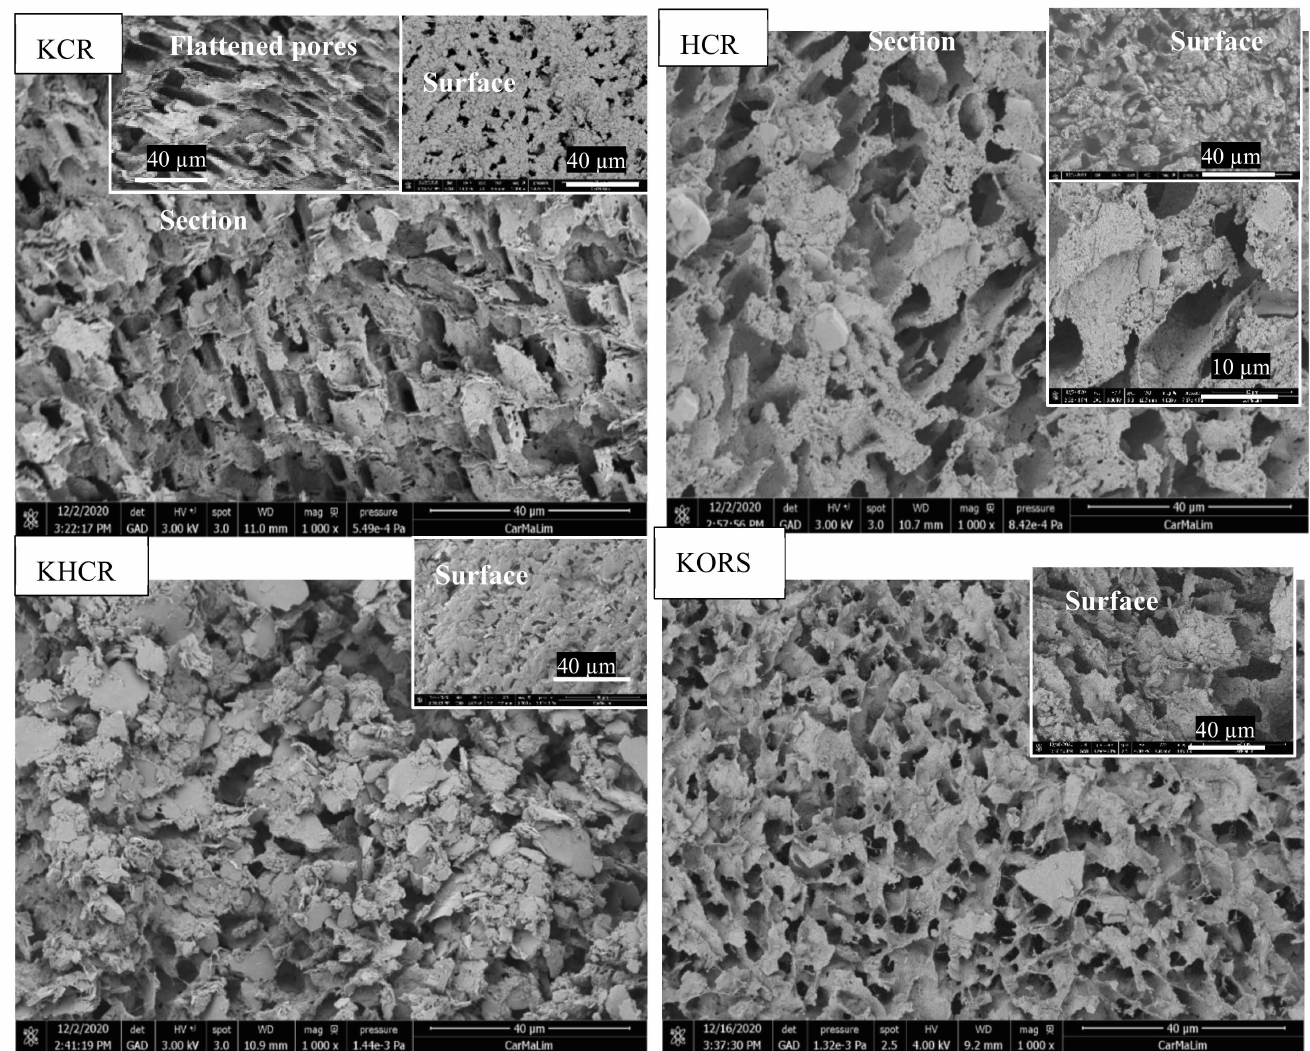
Figure 7. SEM images (surface and section) of the green tapes before sintering at 1200 ◦